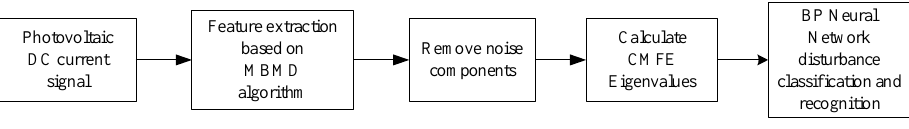
Figure 18. Flow chart of experimental